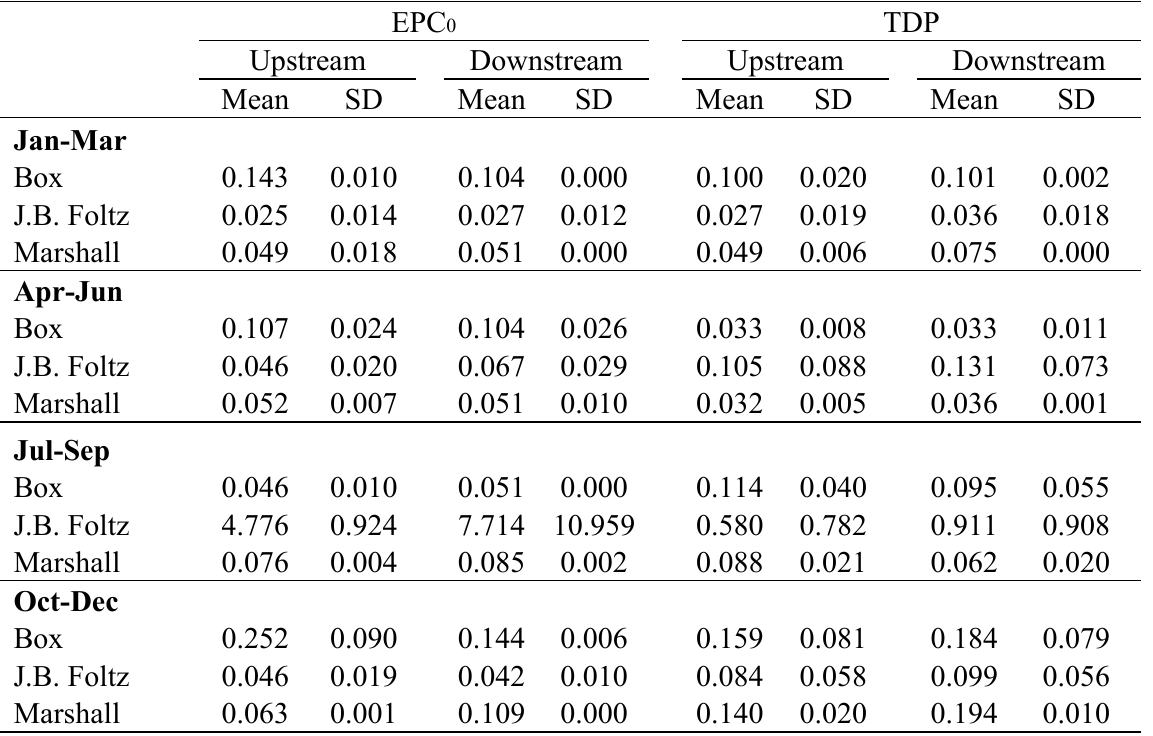
Table 4. Means and standard deviations of upstream and downstream from tile drain outlets EPC 0 and TDP concentrations in the three